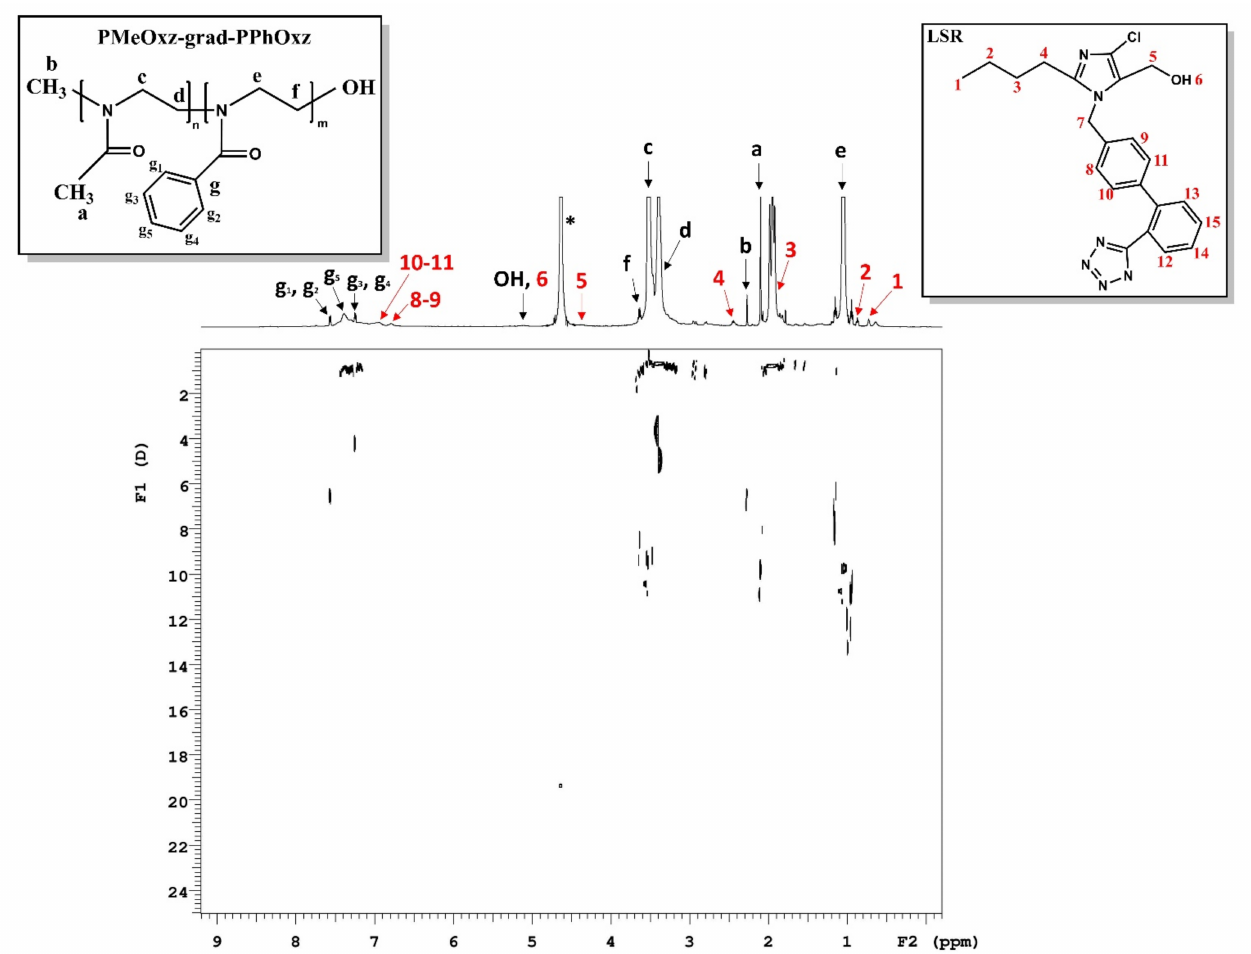
Figure 10. 2D-DOSY spectrum of PMeOxz 72 -grad-PPhOxz 28 + 50% LSR nanocarriers. The black letters (a–g) denote the protons of the copolymer structure, the red letters point to the LSR peaks and the symbol * refers to the solvent D 2